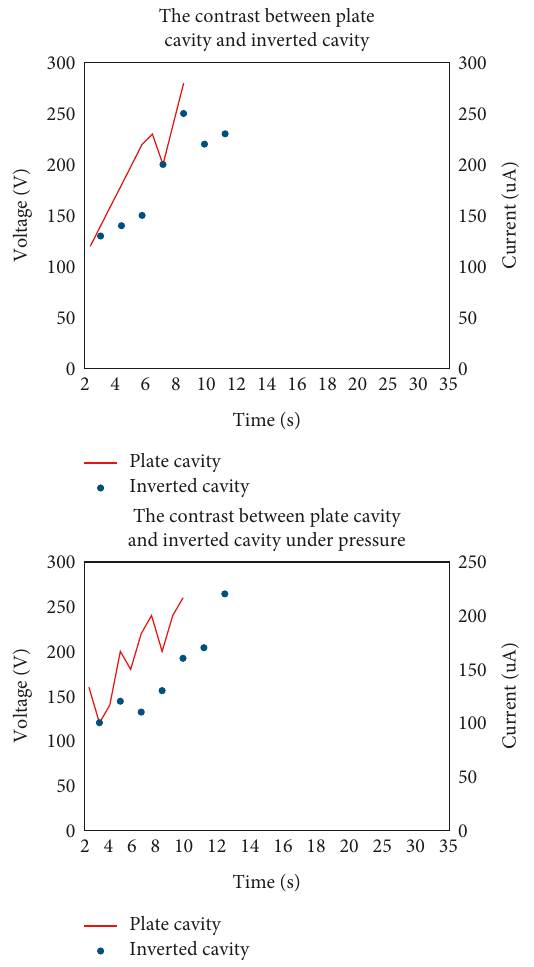
Figure 10: The relationship between the discharge voltage, current and time of the micro-discharger. (a) Contrast between plate cavity and inverted cavity. (b) Contrast between plate cavity and inverted cavity under